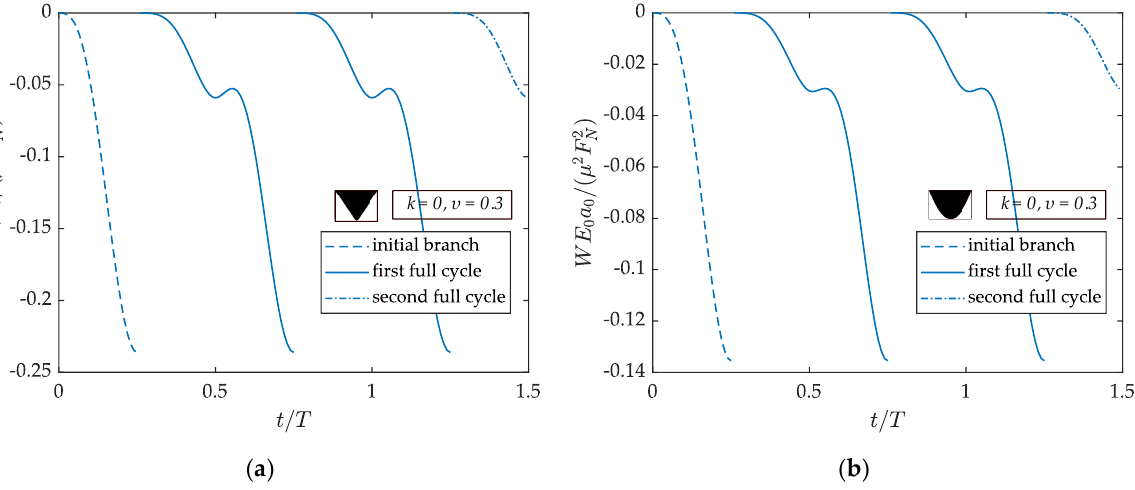
Figure 6. Time-dependent dissipation energy of an indenter with homogenous material: ( a ) for the conical indenter; ( b ) for the parabolic indenter.